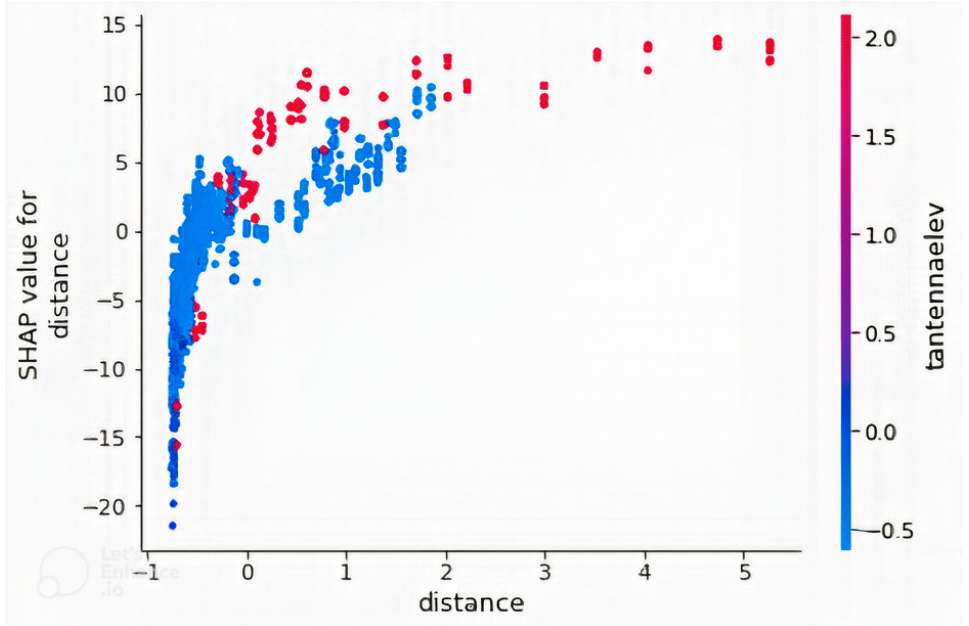
Figure 8. Dependence plot of the feature “distance” in a model with non-image features only with feature “tantennaelev”. Feature “distance” has the highest interaction index with